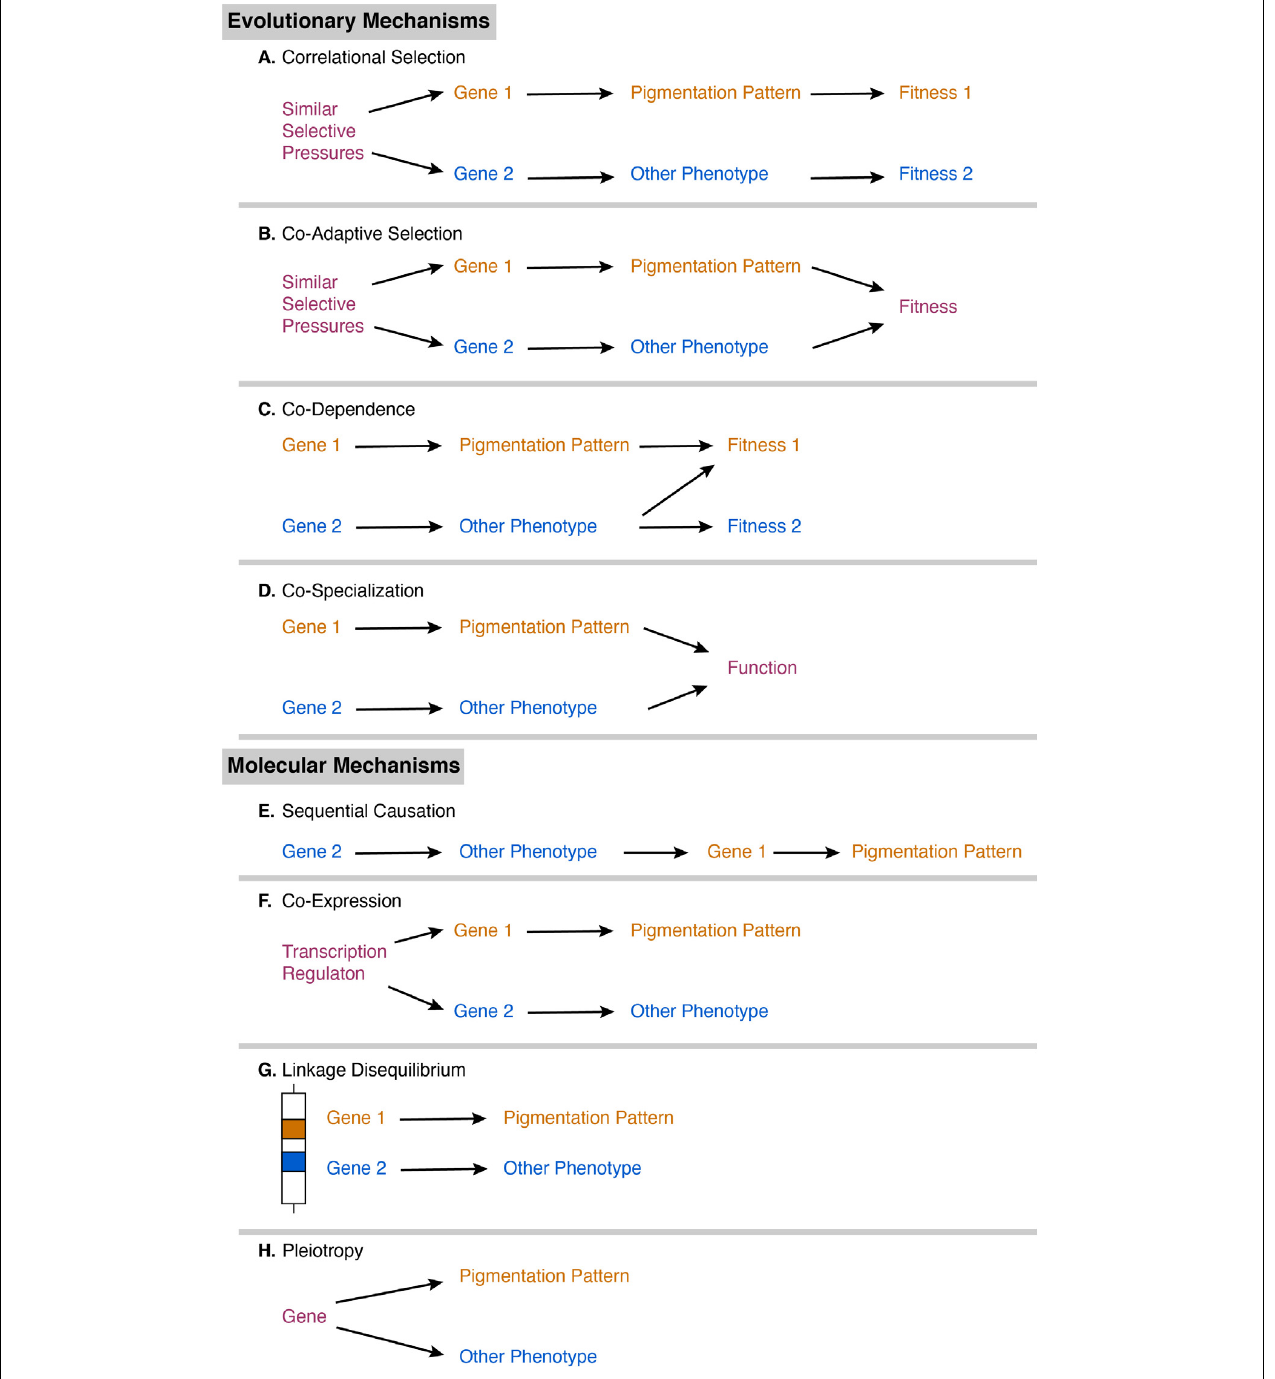
FIGURE 1 | Diagram of proposed evolutionary mechanisms (A–D) and molecular mechanisms (E–H) of phenotypic correlation. Pathway component colors indicate whether they are specific to the pigmentation pattern (orange), specific to a correlated phenotype (blue), or function in both pathways (purple).